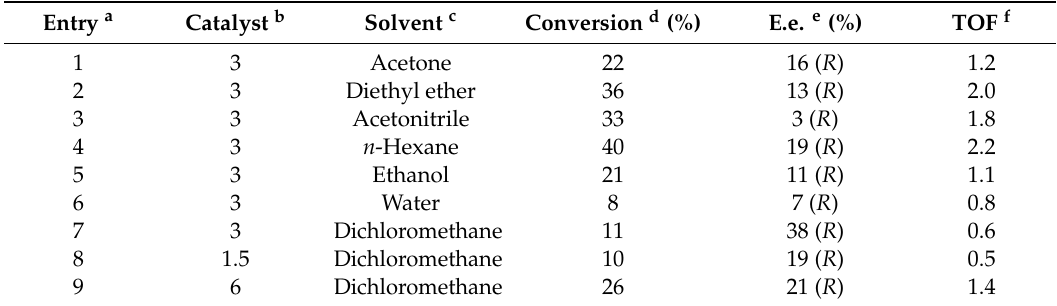
Table 4. Asymmetric epoxidation of styrene for study of catalytic